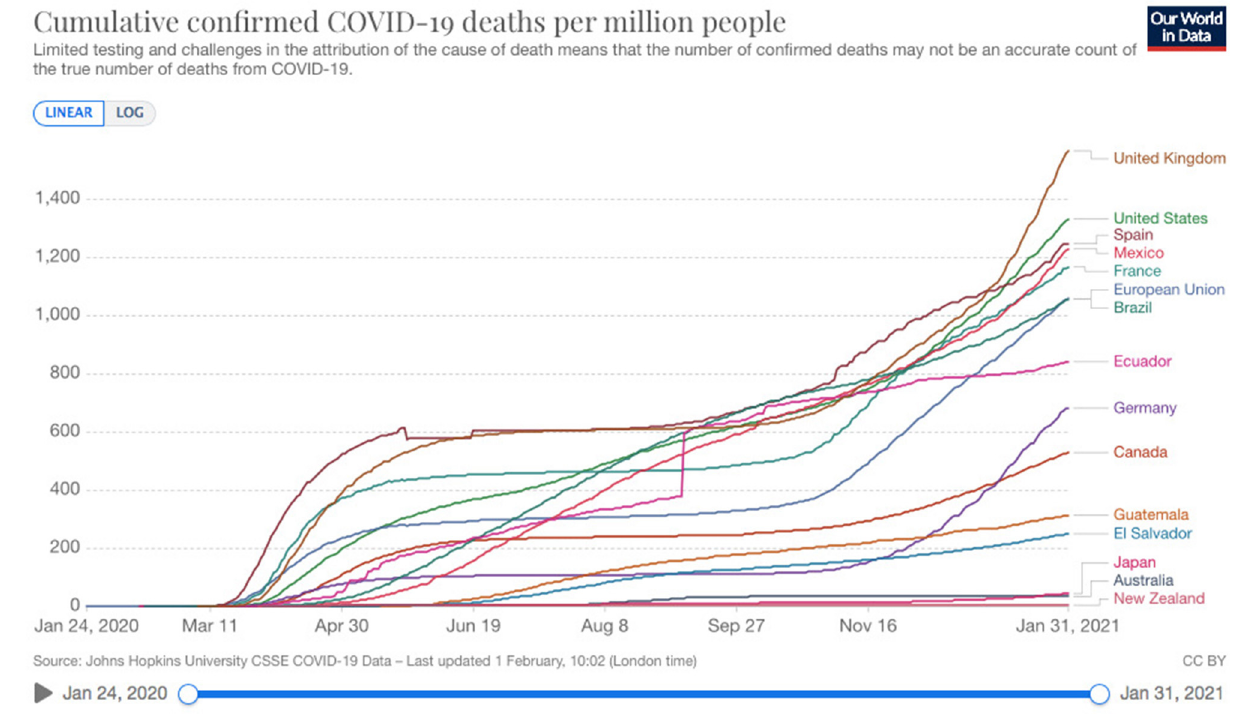
FIGURE 3 | Our World in Data from the European Center for Disease Control January 31, 2021; https://www.ecdc.europa.eu/en.